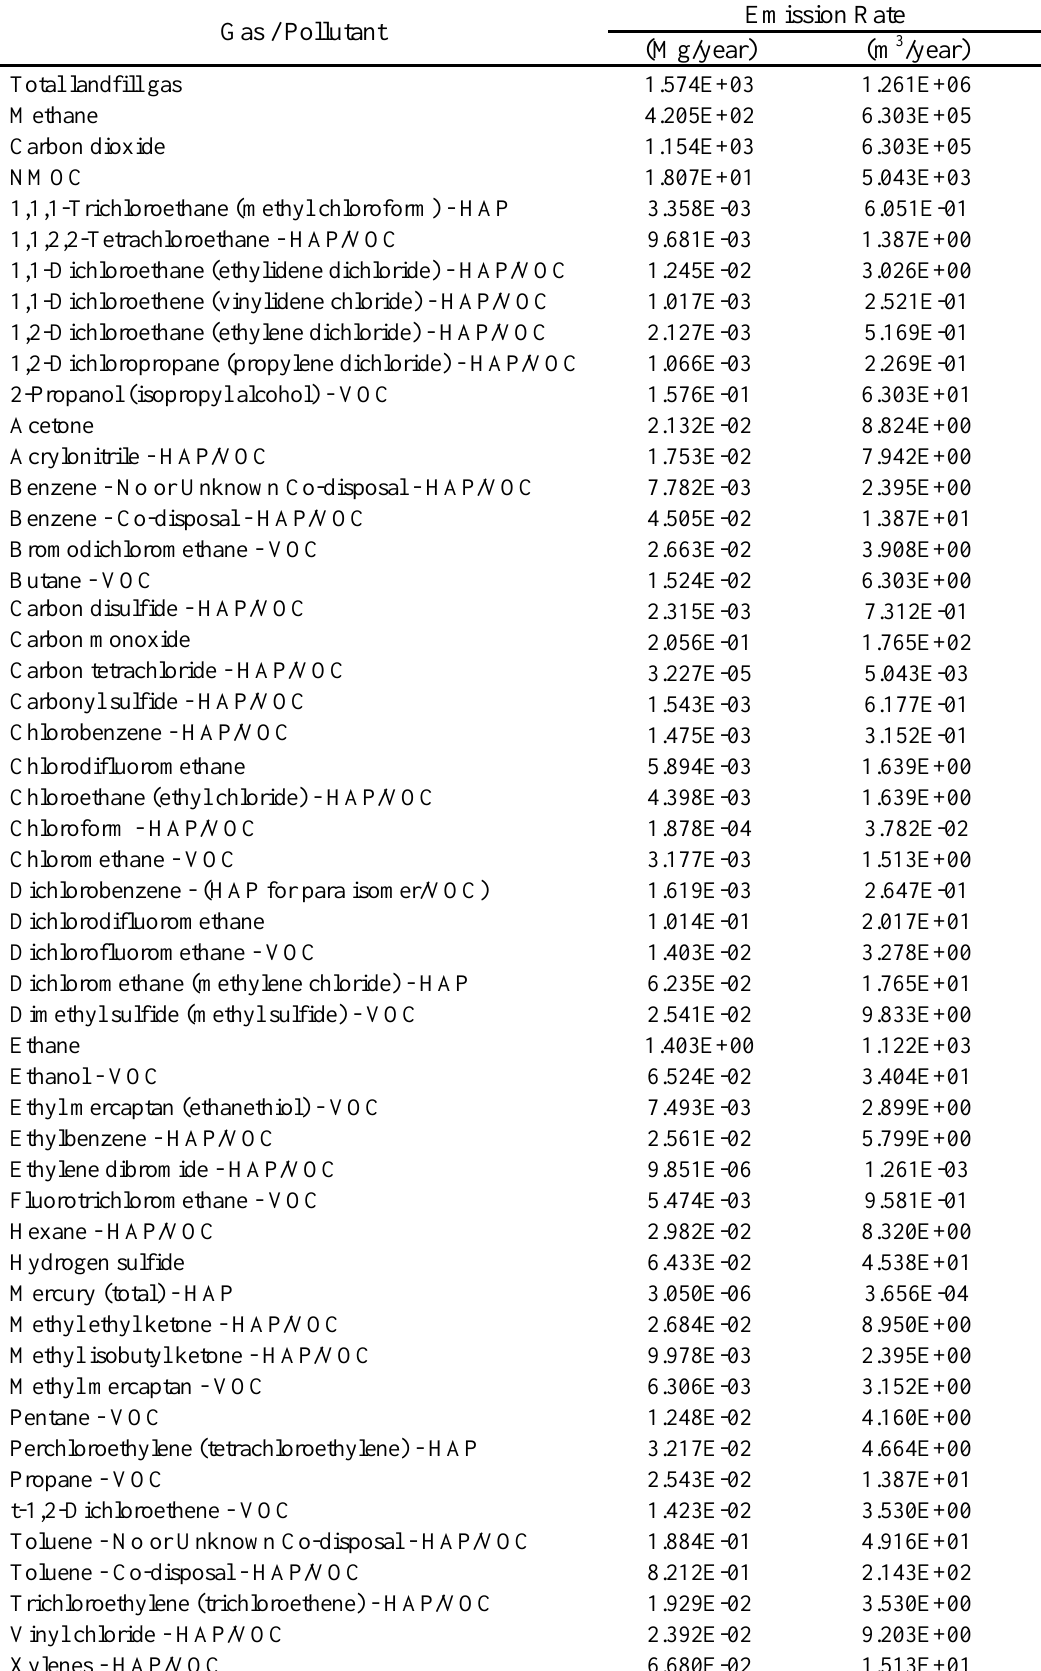
Table 5. The amount of gases and pollutants produced in the province's landfills in 2037,